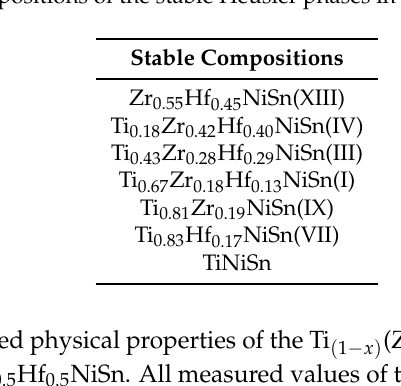
Table 8. Compositions of the stable Heusler phases in an error range of 3%.